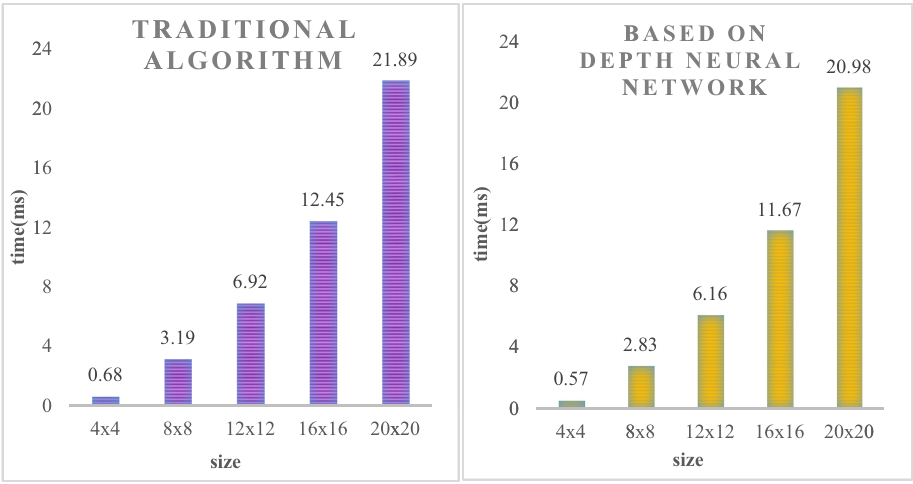
Figure 7: The calculation time of the two algorithms under the serial